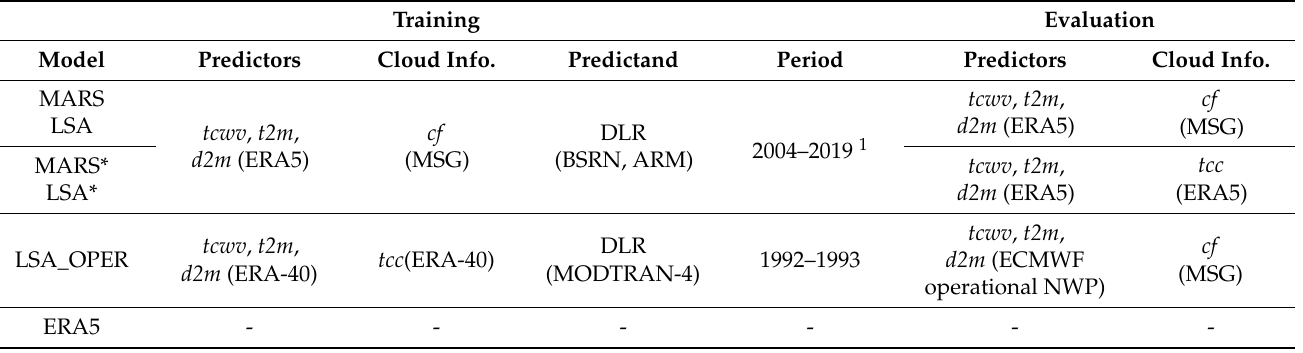
Table 2. List of models used in the analysis, including respective predictors, predictands, and cloud information, for the training and evaluation periods. Training Evaluation Model Predictors Cloud Info. Predictand Period Predictors Cloud